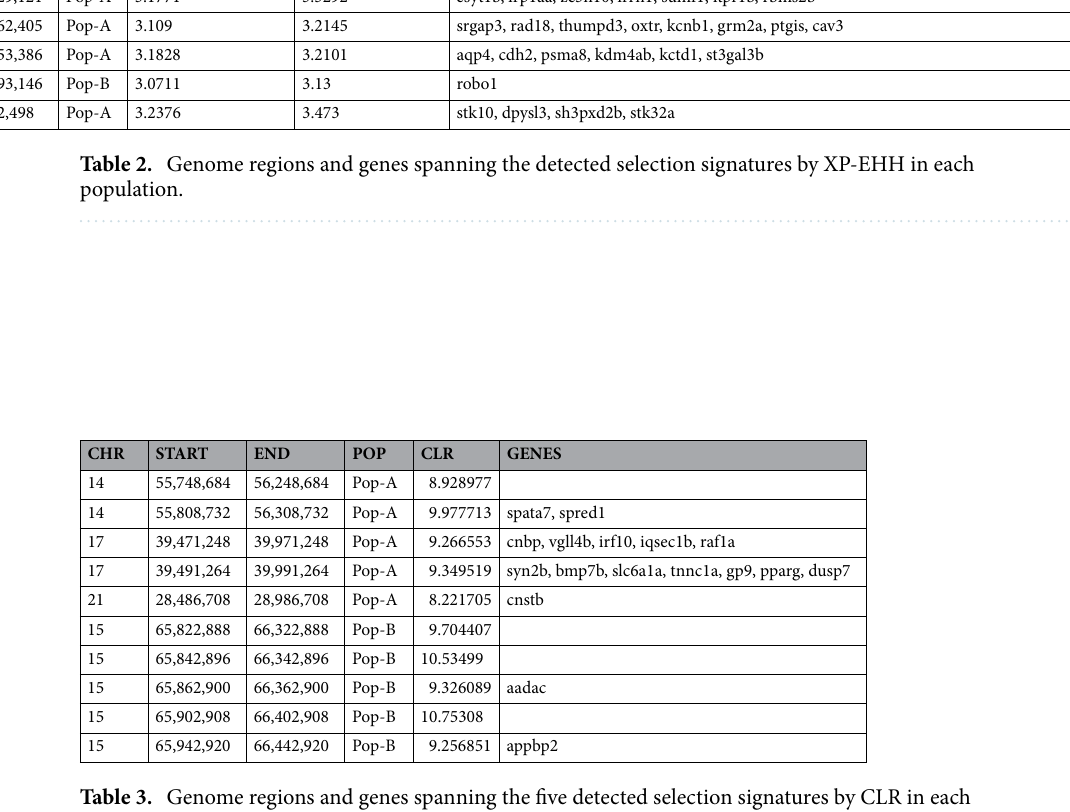
Table 3. Genome regions and genes spanning the five detected selection signatures by CLR in each